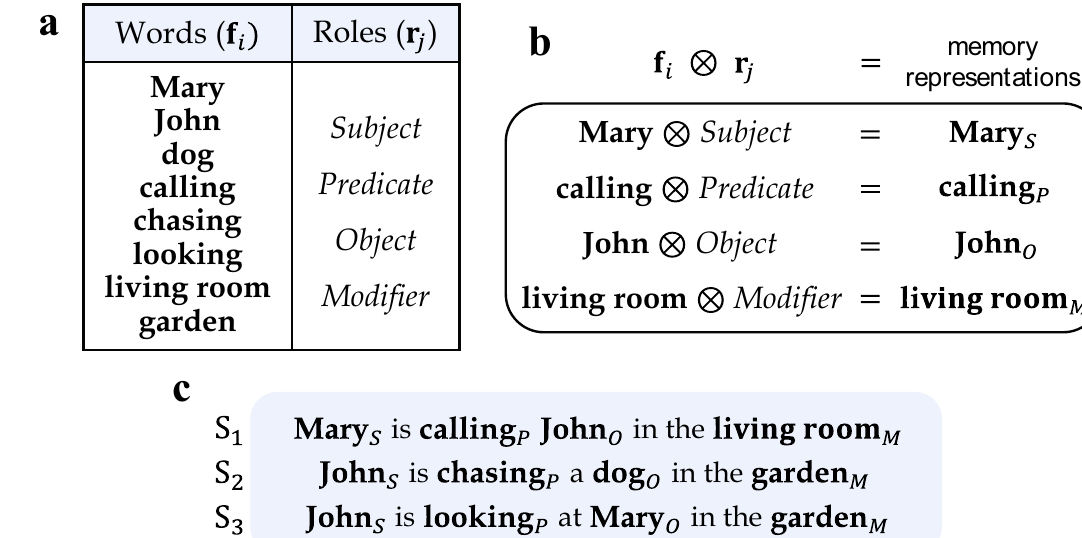
Figure 7. ( a ) List of words and roles used for the external input f i and the tag r j . ( b ) Descriptive explanation on constructing memory representations. ( c ) Three sentences S 1 , S 2 and S 3 generated by grouping memory representations. Note that the words John , Mary and garden appear several times in different contexts.